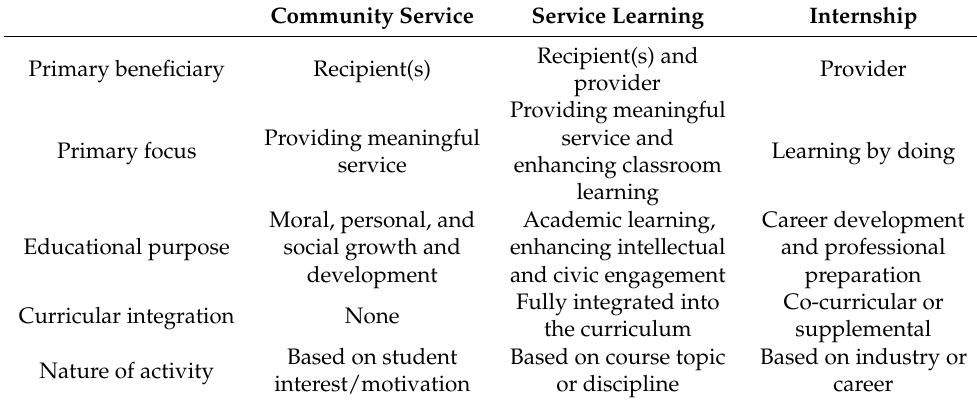
Table 6. Differences between community service, service learning, and internships. Community